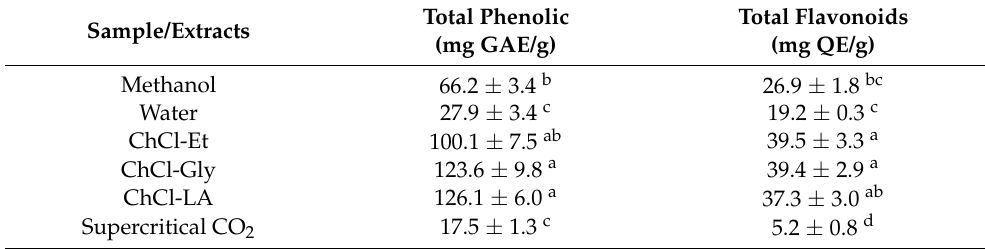
Table 1. Total phenolic and total flavonoid contents in oregano extracts ( Lippia graveolens ).